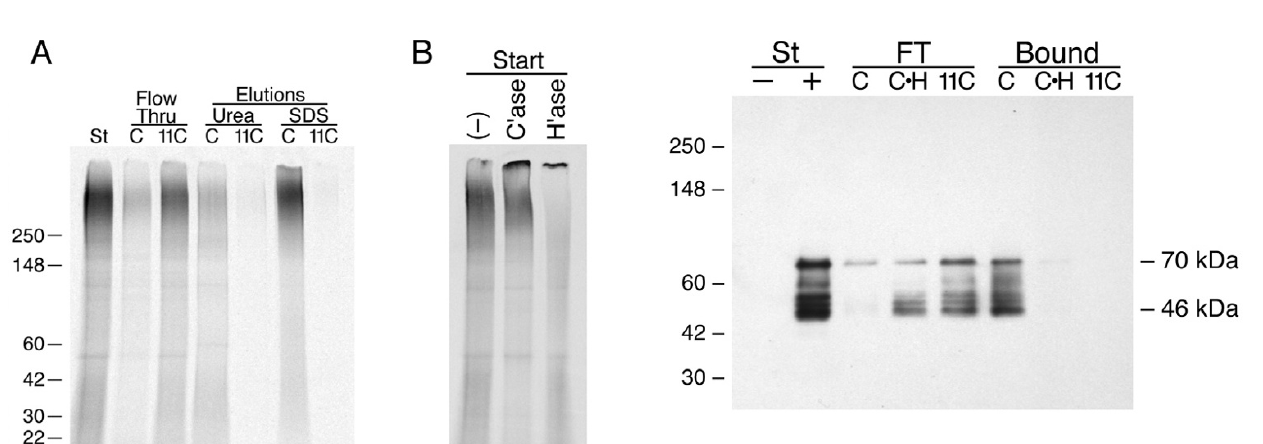
Figure 9 Affinity chromatography of 35 SO 4 -labeled proteogly- cans on III1-C Sepharose. Panel A. RASMCs were labeled with 35 SO , which preferentially labels the glycosaminoglycan 4 chains of proteoglycans. Cells were lysed in NP40 buffer and lysates were applied to either III1-C Sepharose (C lanes) or III 11-C Sepharose (11C lanes) columns. The flow through fractions were collected (Flow Thru lanes), the columns were washed, and the bound material was eluted by first applying 8 M urea elution buffer (Urea lanes), washing the columns with PBS, then collecting the Sepharose beads and boiling them in SDS-PAGE sample buffer (SDS lanes). The lane labeled St shows a sample of the starting material. All samples were separated on SDS-PAGE gels then detected by phosphorimager analysis. Numbers to the left of the panel indicate the migration of molecular mass markers (kDa). Panel B. Samples of the starting material were treated with either no enzyme ((-)), or with 0.03 u/ml chondroitinase ABC (C'ase), or 0.03 u/ml heparitinase (H'ase), then analyzed by SDS-PAGE and phosphorimager. The experiment was performed twice with similar results both times.